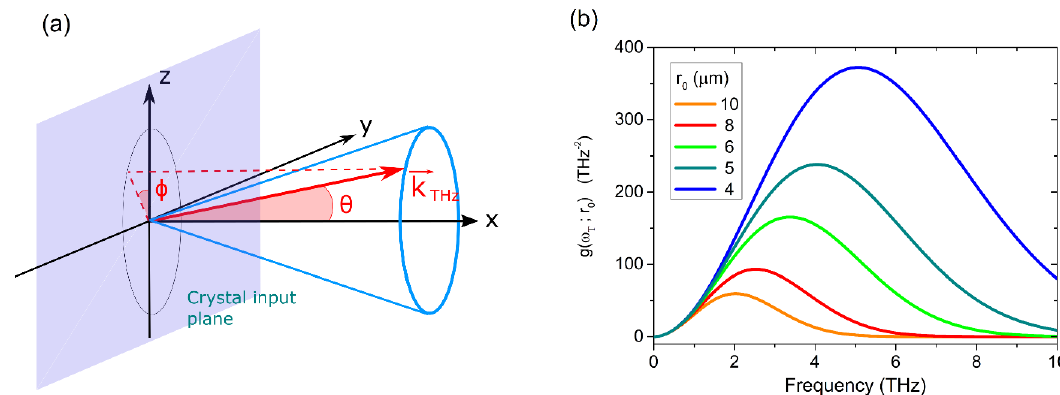
Figure 1. ( a ) Polar coordinates reference system with respect to the waveguide input facet. ( b ) Accessible THz bandwidth for a continuous wave (CW) waveguided difference frequency generation (DFG) process in MgO-doped Lithium Niobate (LN). Different lines correspond to different guided mode radii between 4 μ m and 10 μ m.